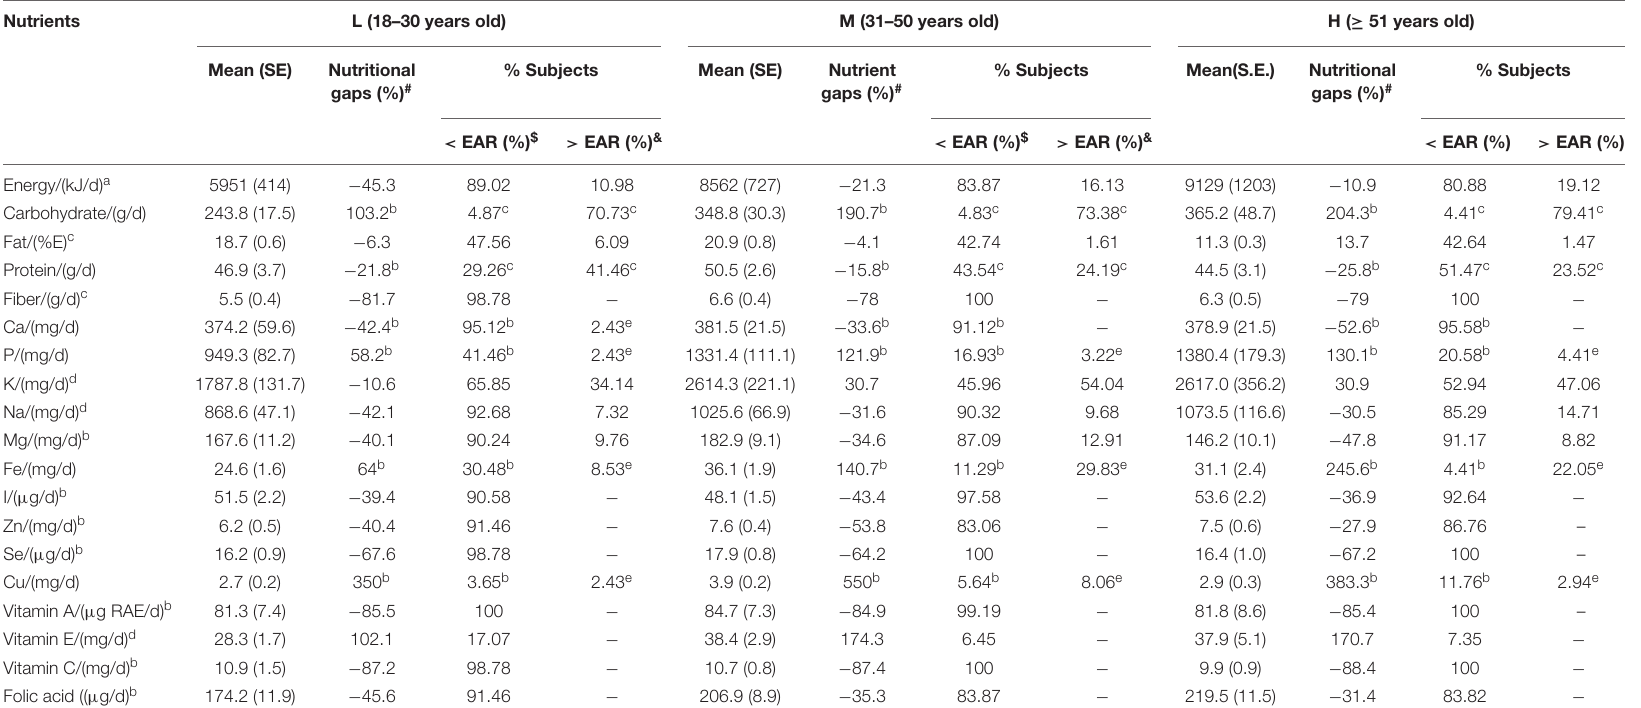
TABLE 4 | Nutrient gaps and prevalence of inadequate and excessive intake of nutrients by age group.